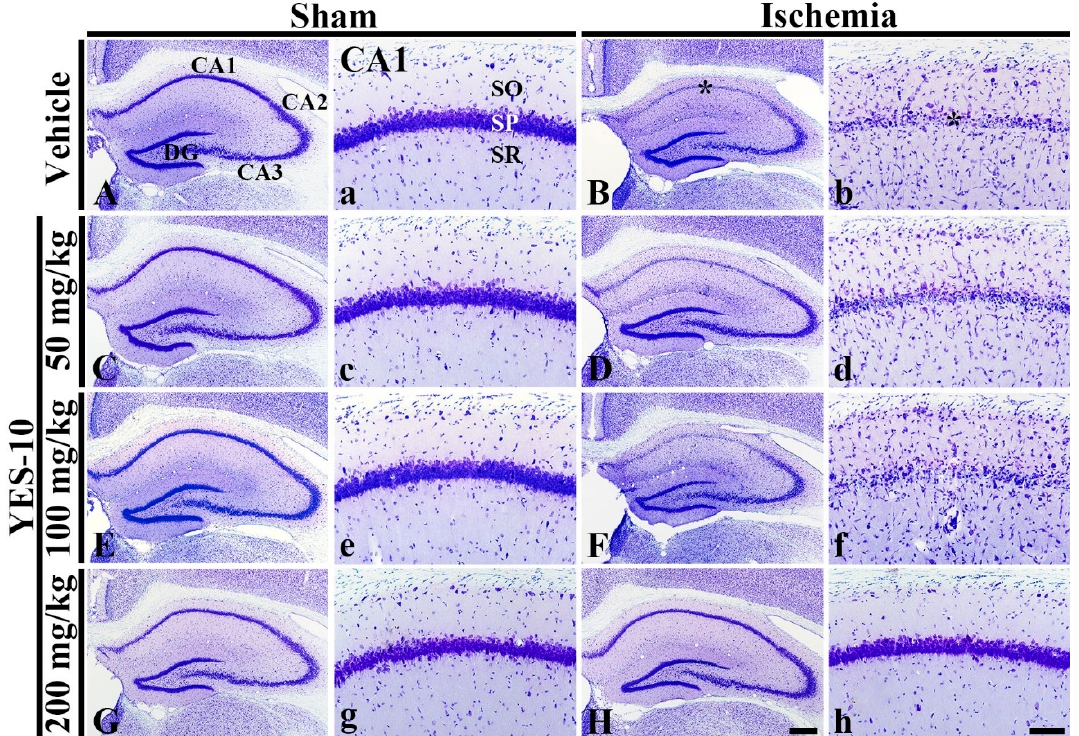
Figure 1. CV staining in the hippocampus ( A – H ) and CA1 field ( a – h ) of the vehicle/sham ( A , a ), 50 mg/kg YES-10/sham ( C , c ), 100 mg/kg YES-10/sham ( E , e ), 200 mg/kg YES-10/sham ( G , g ), vehicle/ischemia ( B , b ), 50 mg/kg YES-10/ischemia (D, d), 100 mg/kg YES-10/ischemia ( F , f ) and 200 mg/kg YES-10/ischemia ( H , h ) groups at 5 days after ischemia/reperfusion. In the vehicle/ischemia group, CV stainability is significantly decreased in the stratum pyramidal (SP) (asterisks) of the CA1 field. In the 50 and 100 mg/kg YES-10/ischemia groups, CV stainability is similar to that in the vehicle/ischemia group. However, in the YES-10/ischemia group, CV stainability is preserved. DG, dentate gyrus; SO, stratum oriens; SR, stratum radiatum. Scale bars = 400 μ m ( A – H ) and 100 μ m ( a – h ).